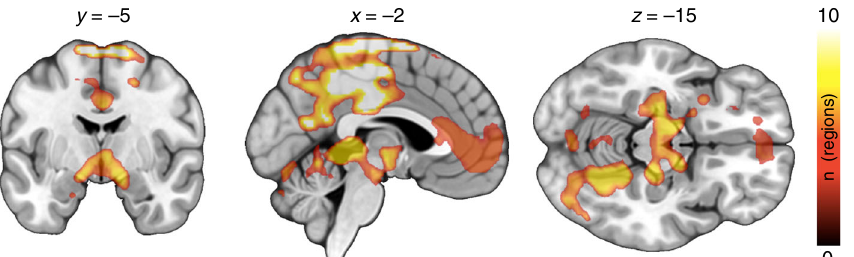
Fig. 6 Cumulative map showing the number of ROIs (out of 10) whose [ 11 C]carfentanil BP ND was correlated ( p < 0.05, FDR corrected at cluster level) with the voxel-wise BOLD responses to palatable versus non-palatable foods in each brain area ( n